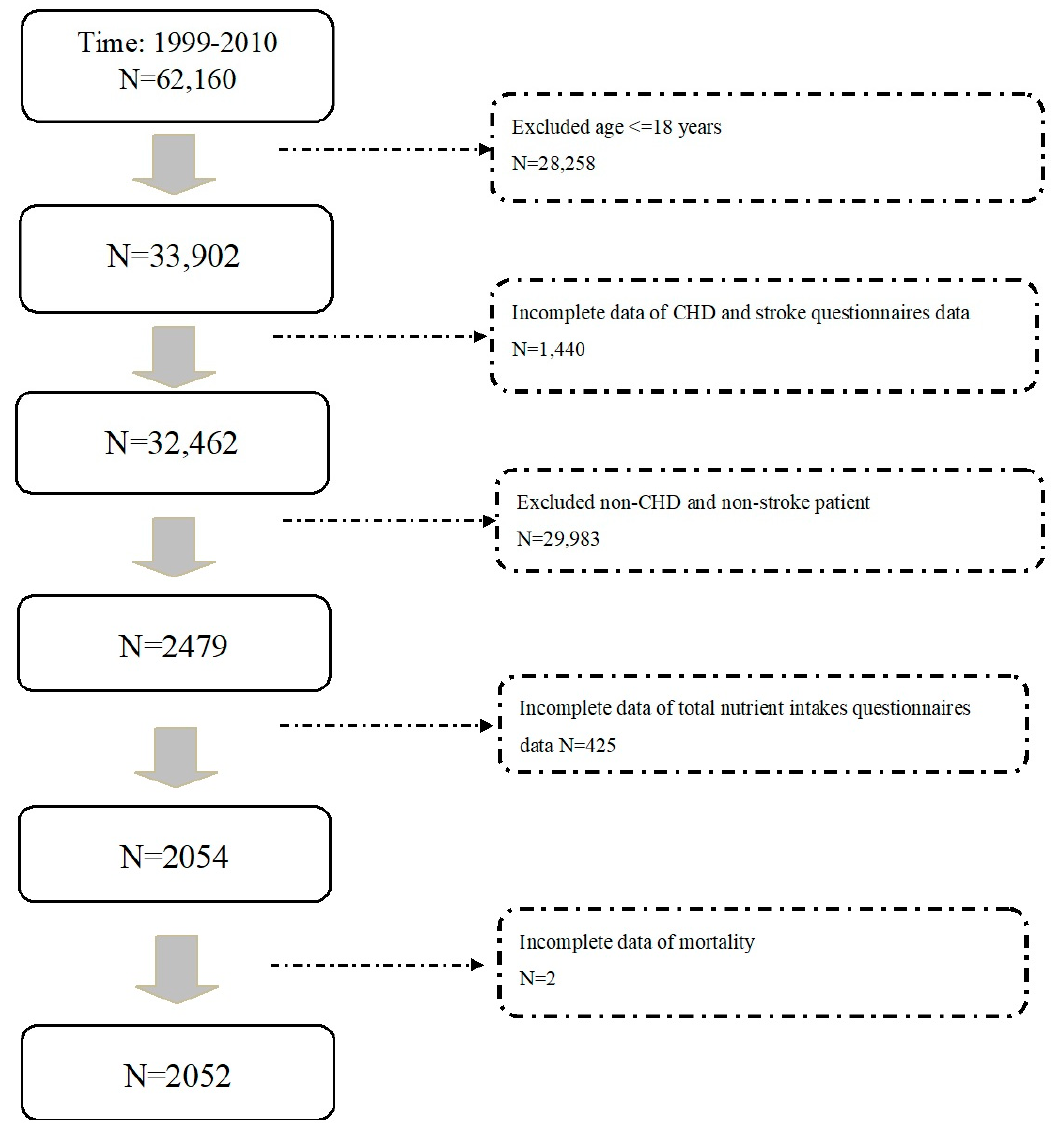
Figure 1. Flow diagram displaying the enrollment of study participants. CHD: coronary heart dis- ease.